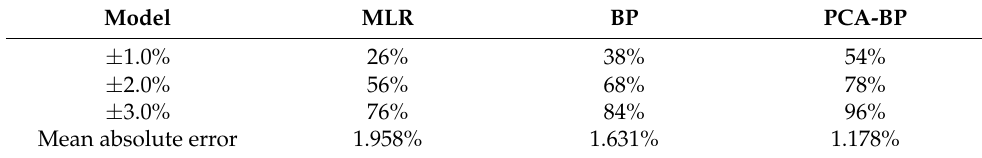
Table 8. Comparison of accuracy and error of three prediction